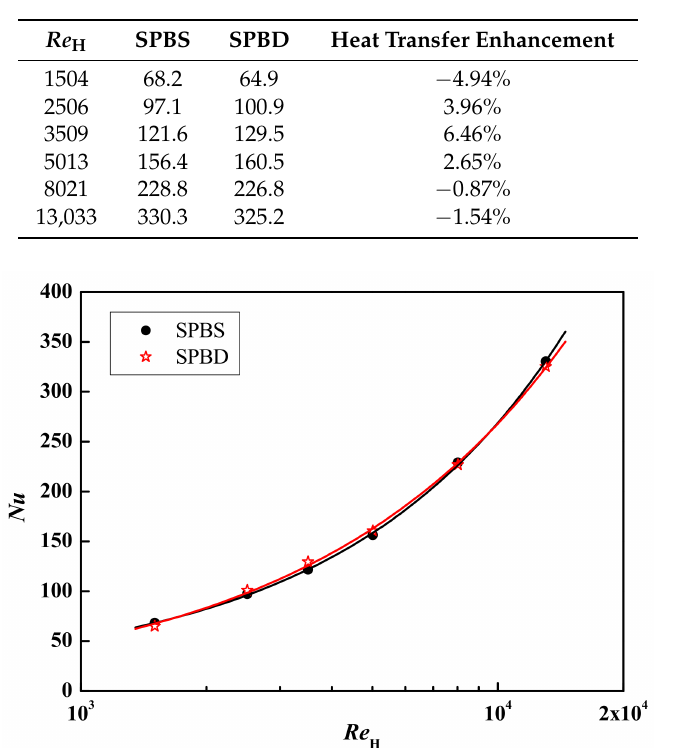
Table 3. The Nusselt number of the structured packed beds with smooth or dimpled spheres at N = 1.00.